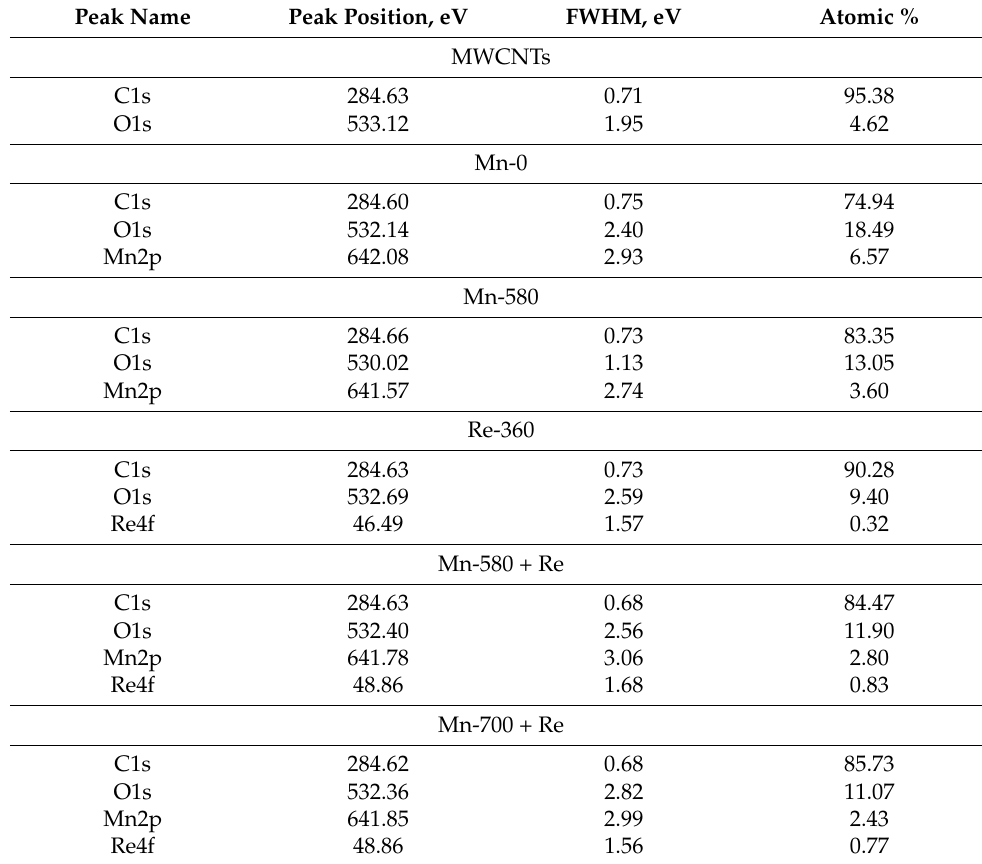
Table 2. Chemical analysis of samples by